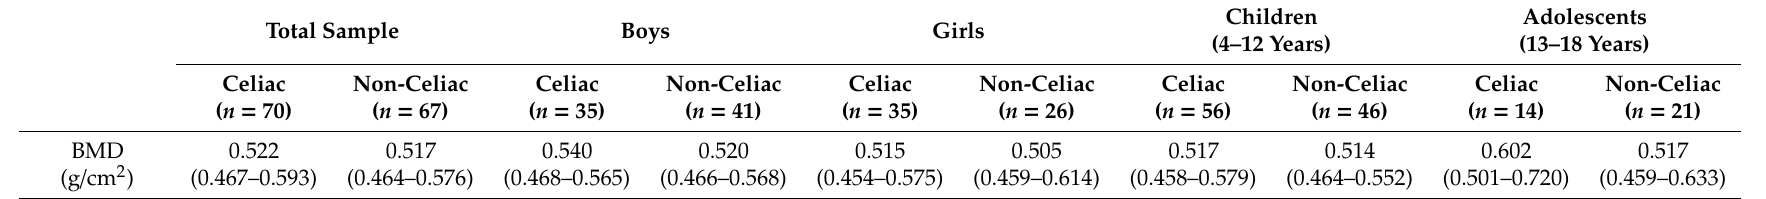
Table 9. Bone mineral density in celiac and non-celiac children and